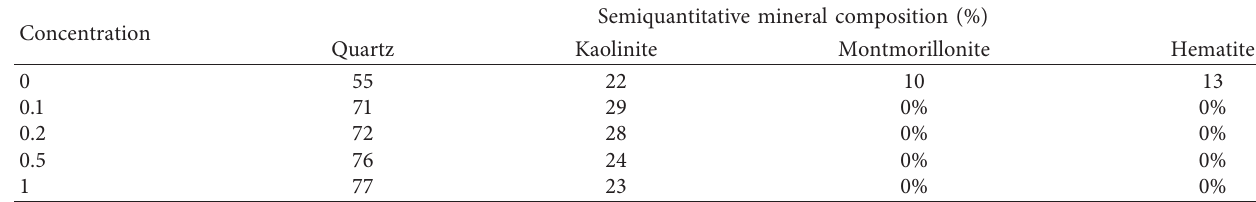
Table 3: Semiquantitation of the